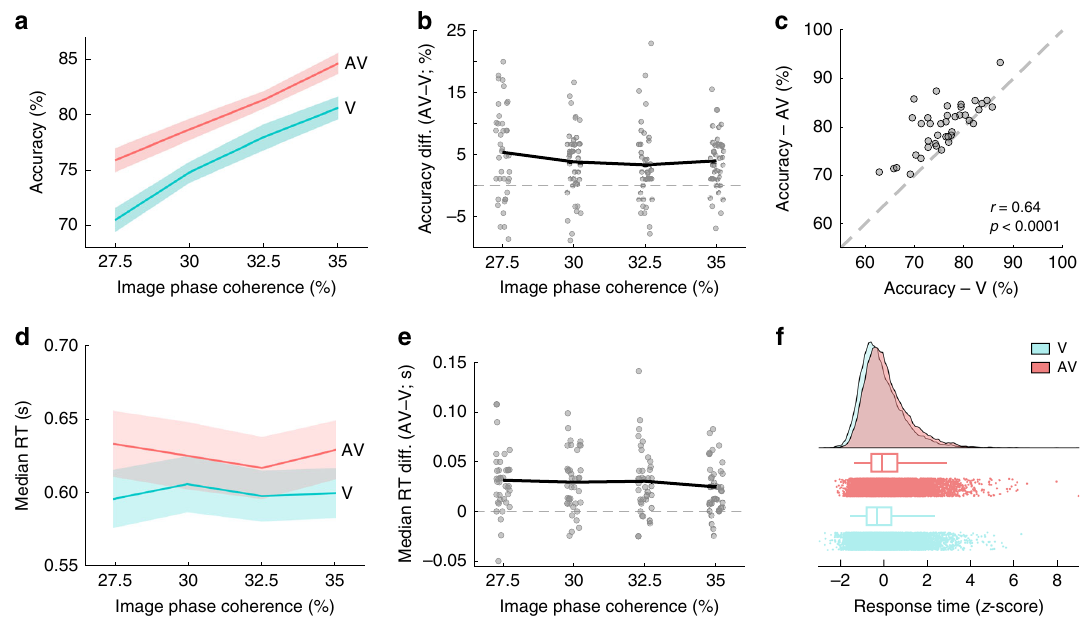
Fig. 2 Behavioral performance. a , d Group averages of a decision accuracy (mean) and d response time (RT; median) across the four levels of visual evidence (phase coherence) and as a function of the visual (V; turquoise) and audiovisual (AV; red) trials. Shaded error bars indicate standard errors of the mean (SEM) and median across participants ( n = 40), respectively. b , e Individual participant behavioral performance changes (AV – V trials) for b decision accuracy and e RT across the four levels of visual evidence (phase coherence). Group averages were computed across n = 40 independent participants. Solid black lines indicate group averages. c Robust bend correlation between individual participant decision accuracy, computed across all four levels of visual evidence (one value per participant), during V and AV trials. Bending (i.e., down-weighting) was performed on 20% of the data points in each direction. Dashed gray line represents equal performance during V and AV trials. Indicated correlation statistics were obtained from a robust bend correlation. f Standardized RTs of single trials. RTs were standardized on the participant level. Dots of the raincloud plot denote single-trial RTs 108 . Source data for this fi gure are provided as a Source data fi